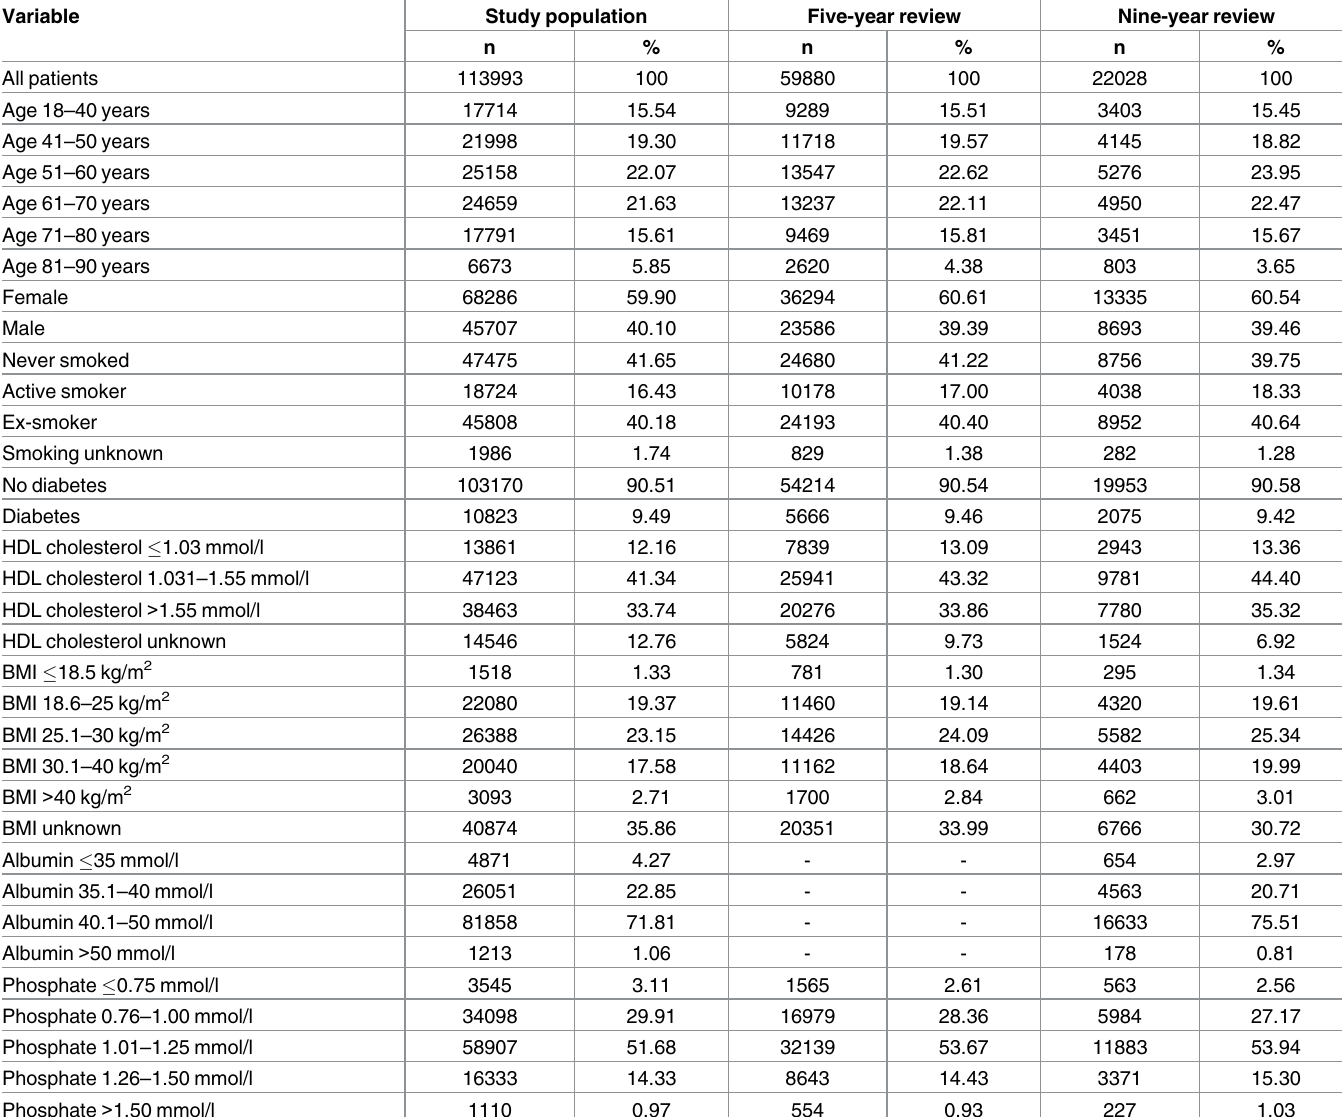
Table 1. Demographic review of patients and their physiological variables retained within our regression